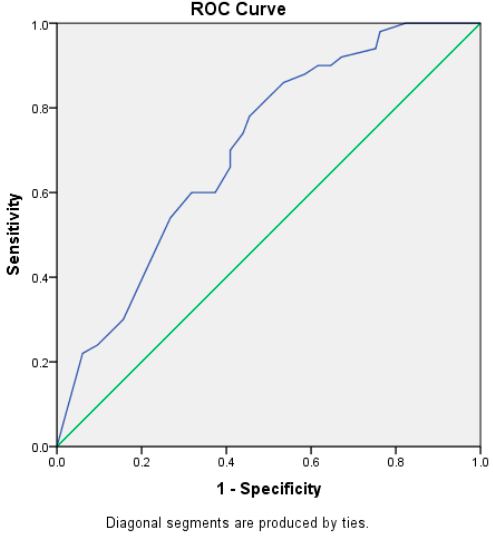
Figure 1. ROC curve. Green line indicates random classifier. Blue line indicates the multivariate model obtained from Table 5.